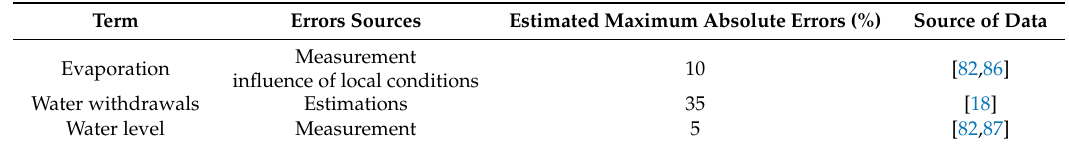
Table 2. Uncertainties for the di ff erent components of water